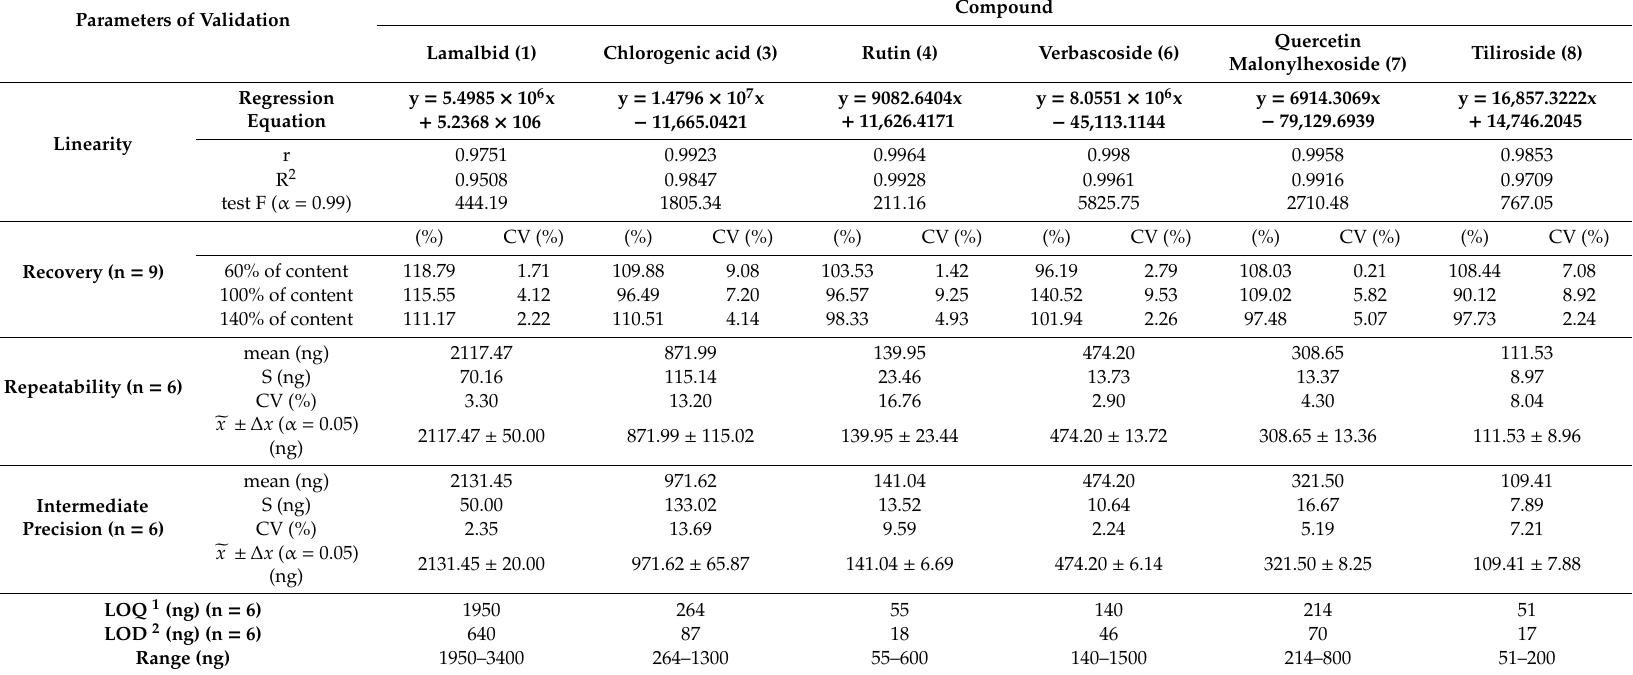
Table 1. Method validation data for the quantitative determination of the six tested